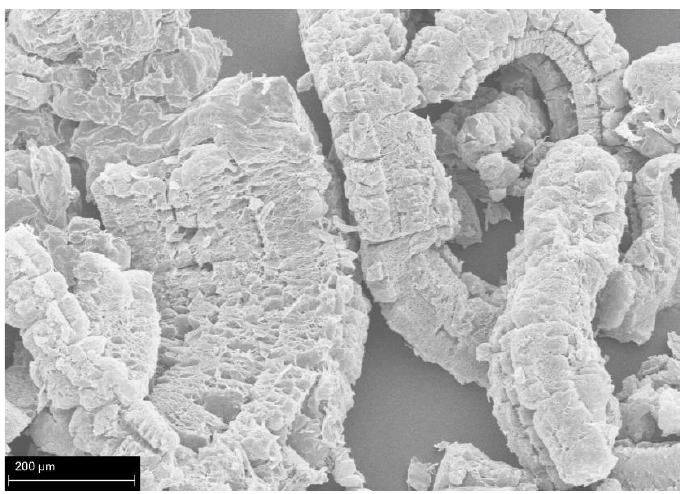
Figure 7. Scanning electron microscope (SEM) image of expanded graphite.